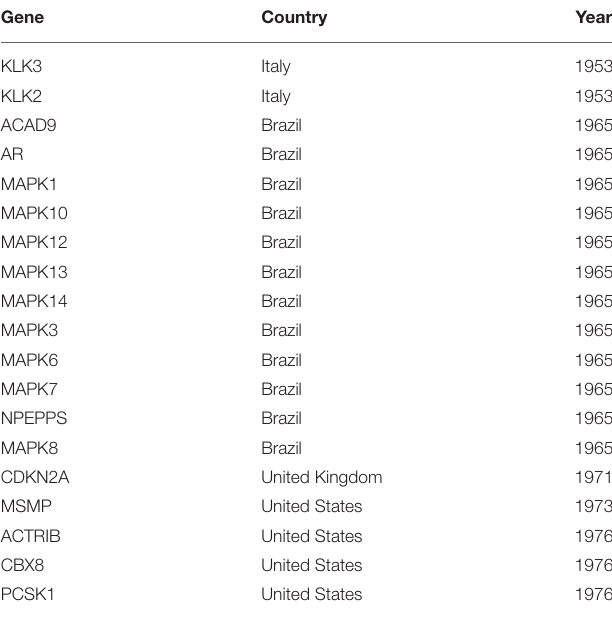
TABLE 3 | The table provides information about the year the first publication about a gene has been found and what country/countries contributed to this publication (see Figure 7